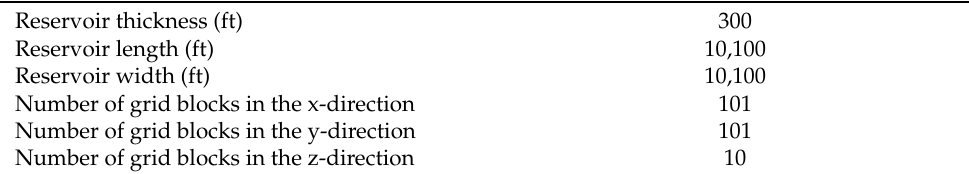
Table 2. Reservoir and grid properties in the numerical